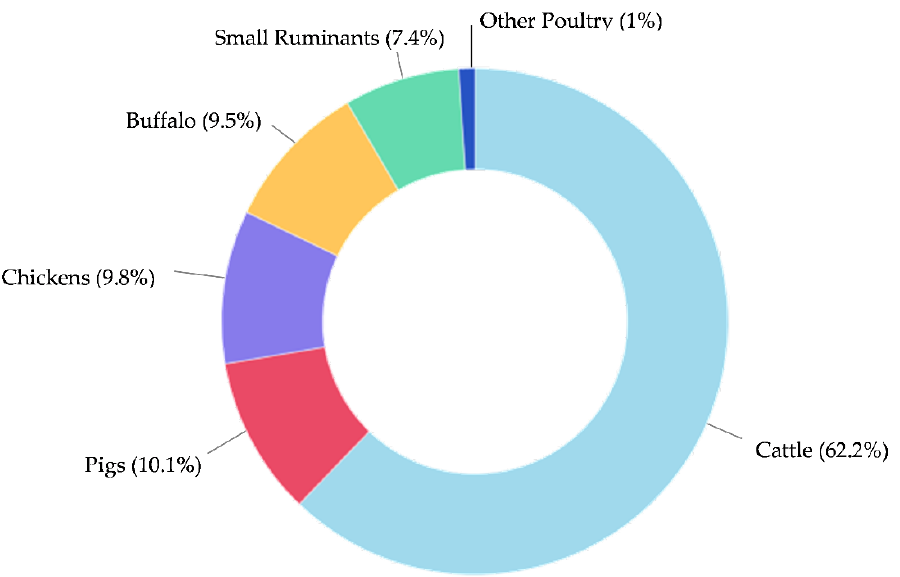
Figure 2. Emissions from livestock (by species). Figure drawn by authors with data source from